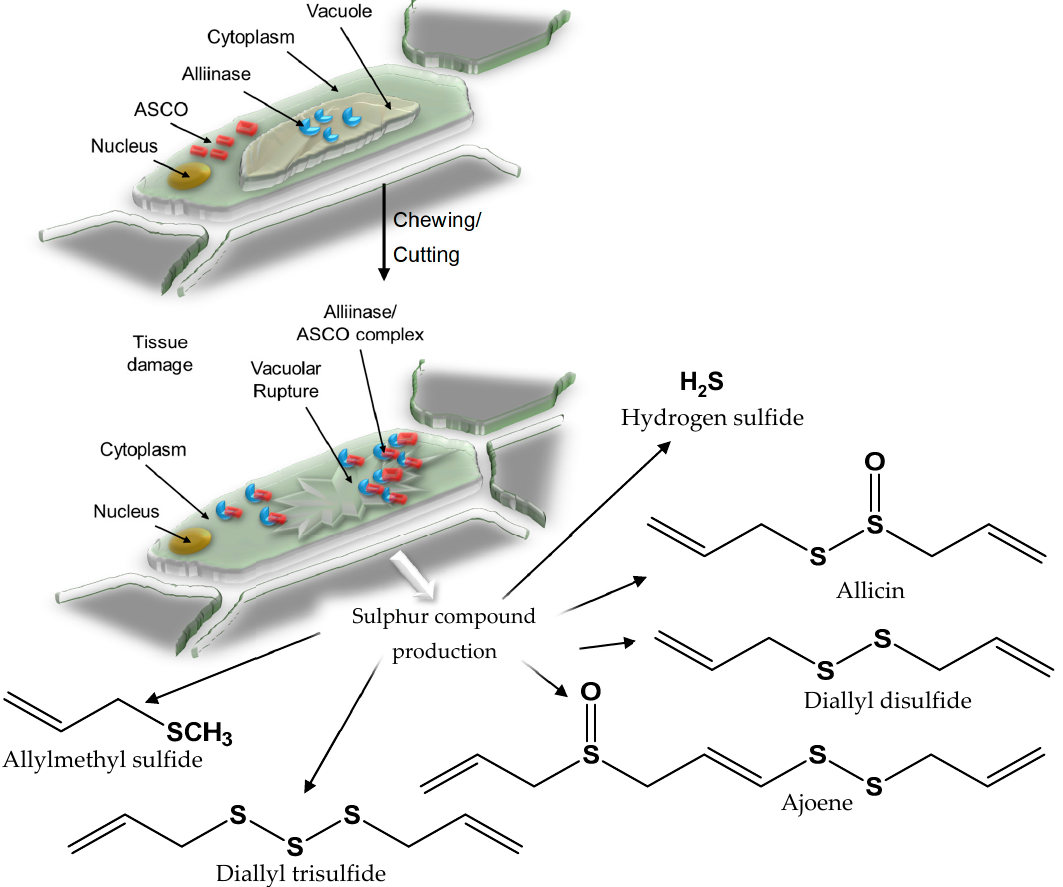
Figure 1. Catabolism of S -alk(en)yl- l -cysteine sulfoxides (ASCOs) by alliinase enzyme generates a spectrum of individual sulfur compounds.